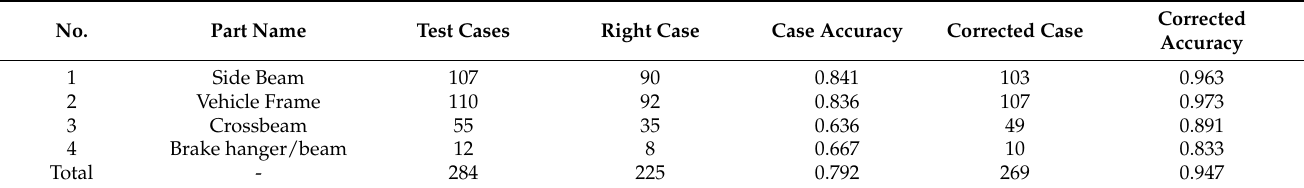
Table 4. Structured document decision